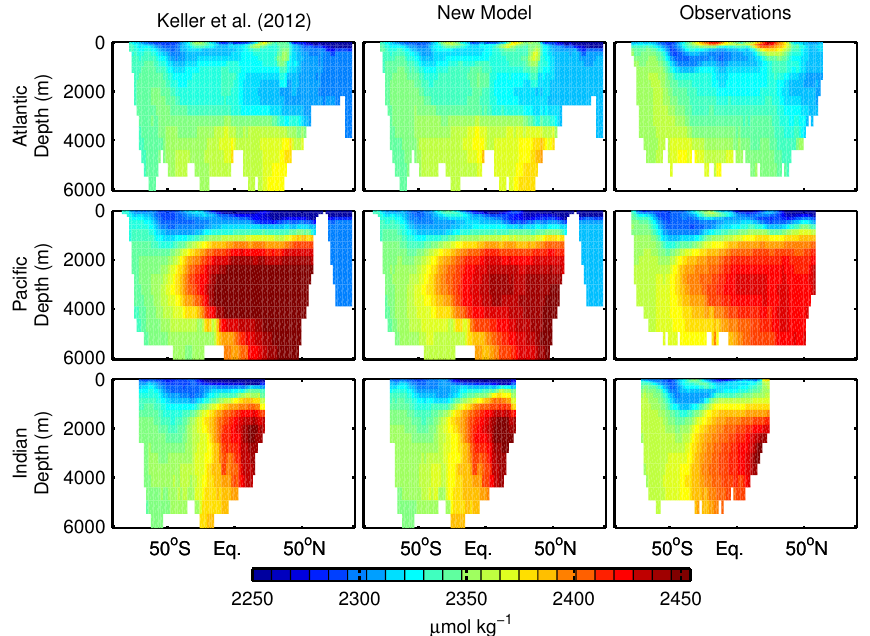
Figure 15. Zonal annual mean alkalinity as simulated with the model by Keller et al. (2012) (left column) and the new model (middle column) in comparison to observations from GLODAP (right column) for the different ocean